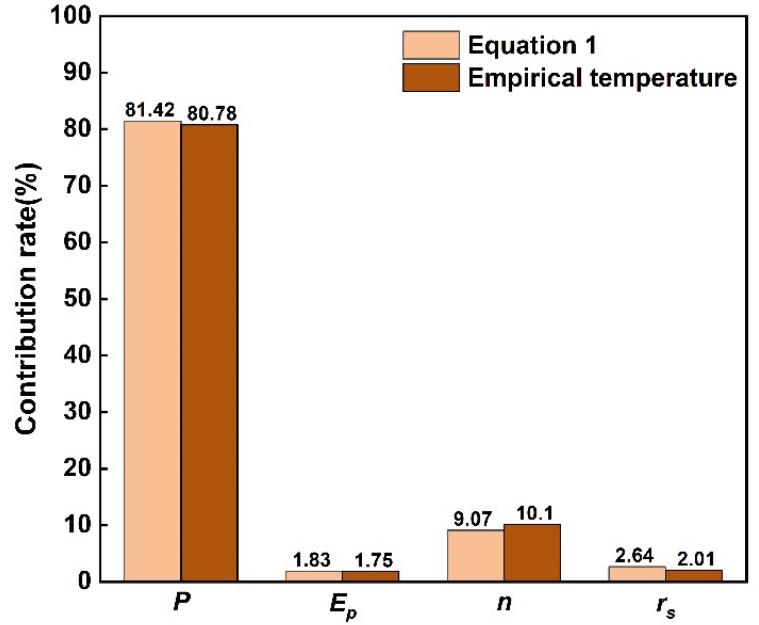
Figure 9. Contribution rates of precipitation ( P ), E P , snow ratio ( r s ), and basin parameter ( n ) changes to runoff change calculated by different methods for distinguishing rainfall and snowfall.